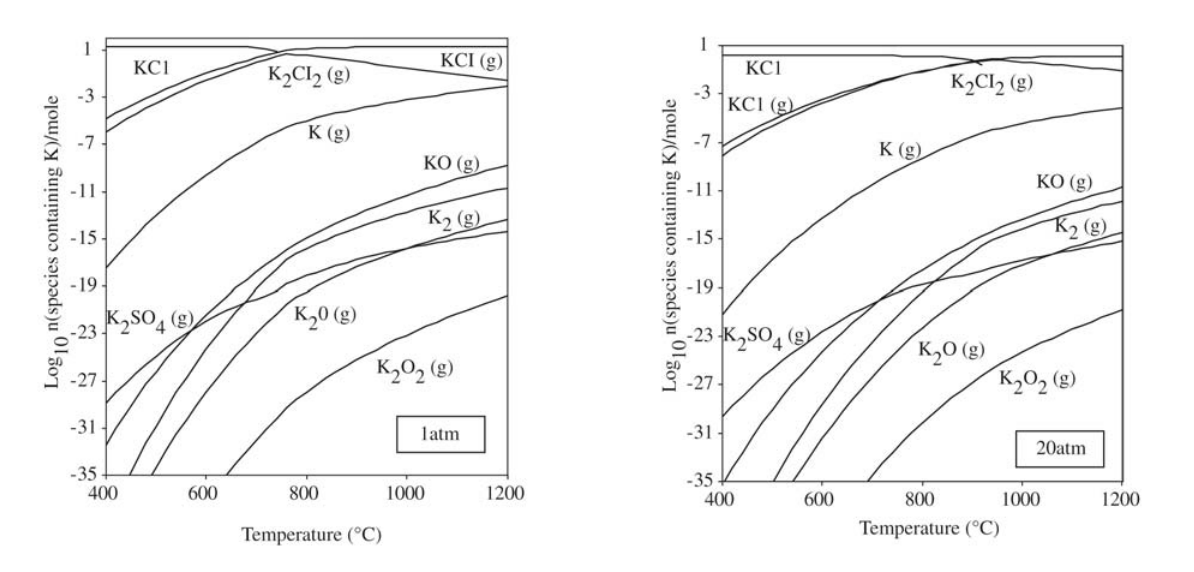
Figure 3 The effect of pressure on K equilibrium diagrams in air-derived fuel